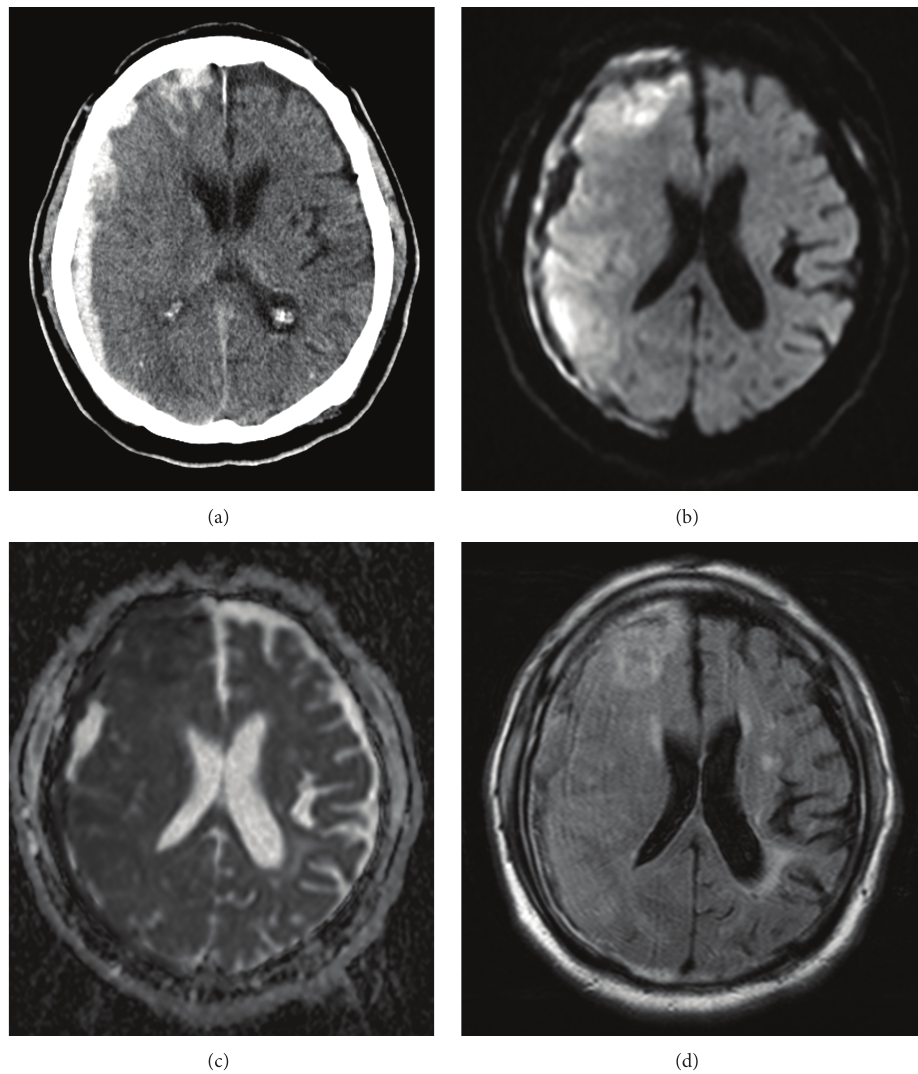
Figure 1: Computed tomography (CT) and magnetic resonance image (MRI) on admission. Brain CT shows a right hemispheric subdural hematoma (a). Diffusion-weighted image of brain MRI shows high signal intensity in frontal and temporal lobes (b). Apparent diffusion coefficient map is low (c) and fluid attenuated inversion recovery shows high signal intensity (d) in the corresponding